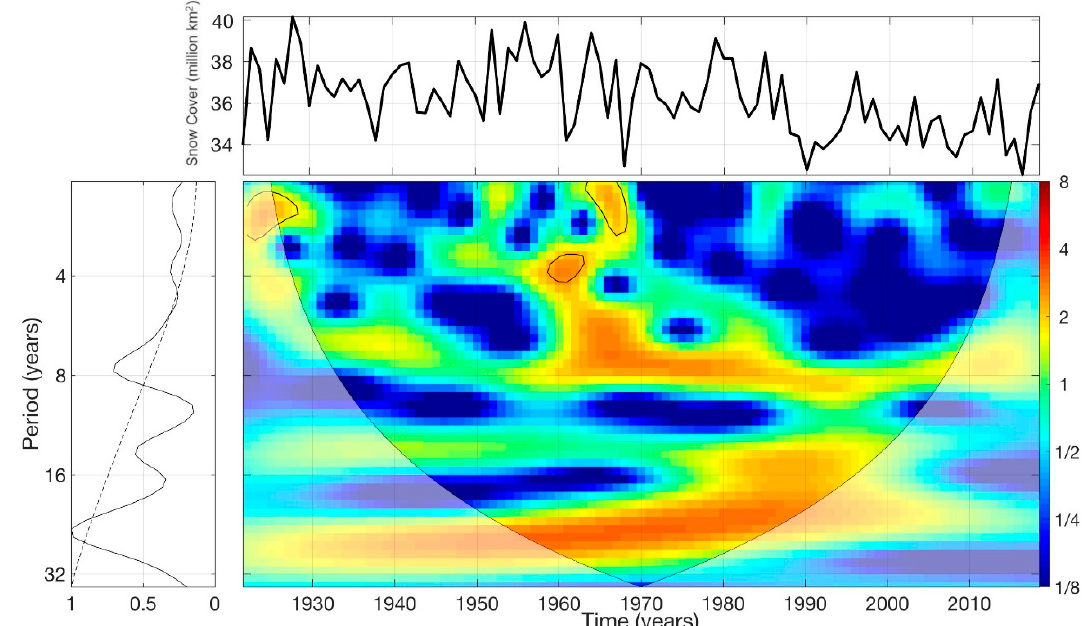
Figure 11. Time-frequency wavelet power (middle panel) of the Northern Hemisphere spring snow cover from 1922–2018. Top panel shows the original time-series, while the left panel shows the global time-averaged spectrum indicating significant (95% above the adopted reference red noise spectrum) oscillations at about 23, 7, 4, and 2.4 years.